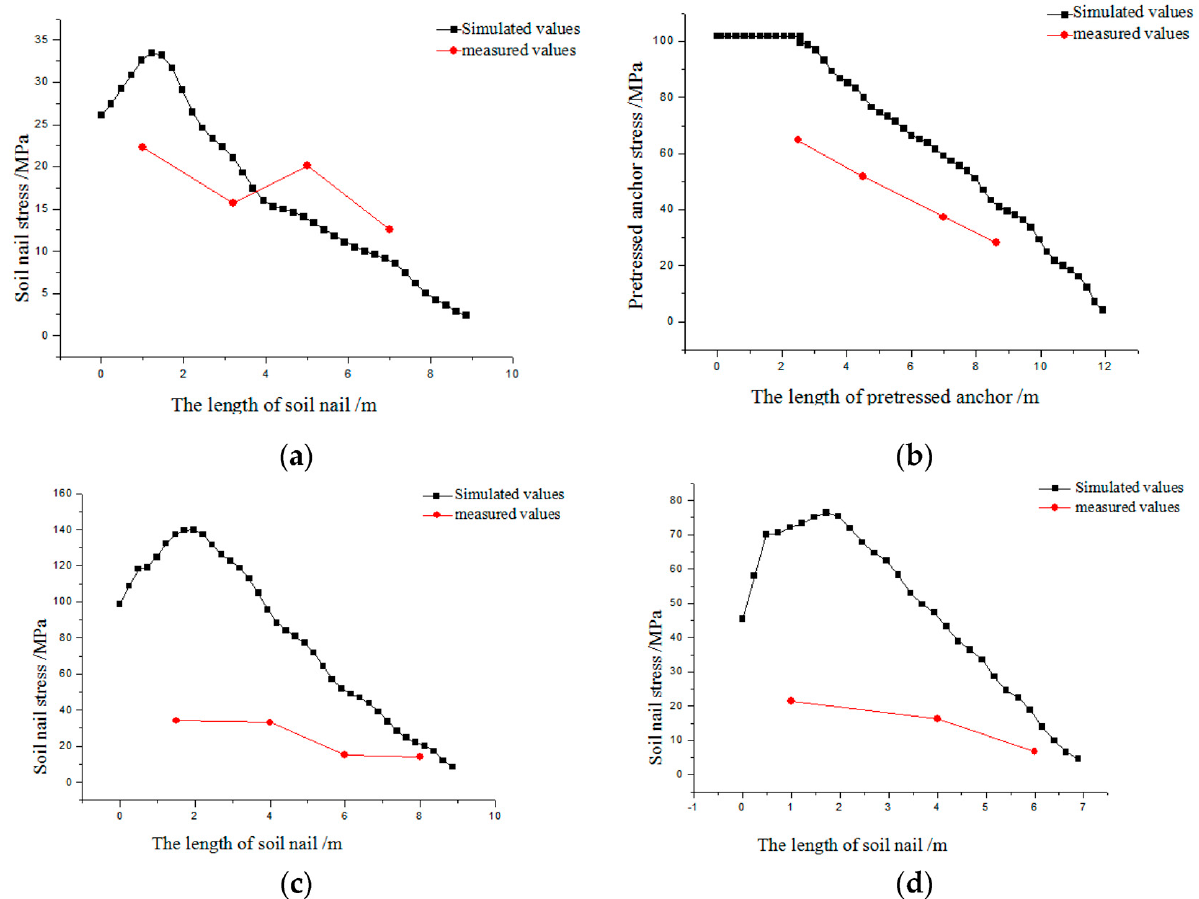
Figure 13. Comparison between simulated and measured values of soil nail stress. ( a ) Stress of the first row of soil nails, ( b ) stress of the second row of soil nails, ( c ) stress of the third row of soil nails and ( d ) stress of the fourth row of soil